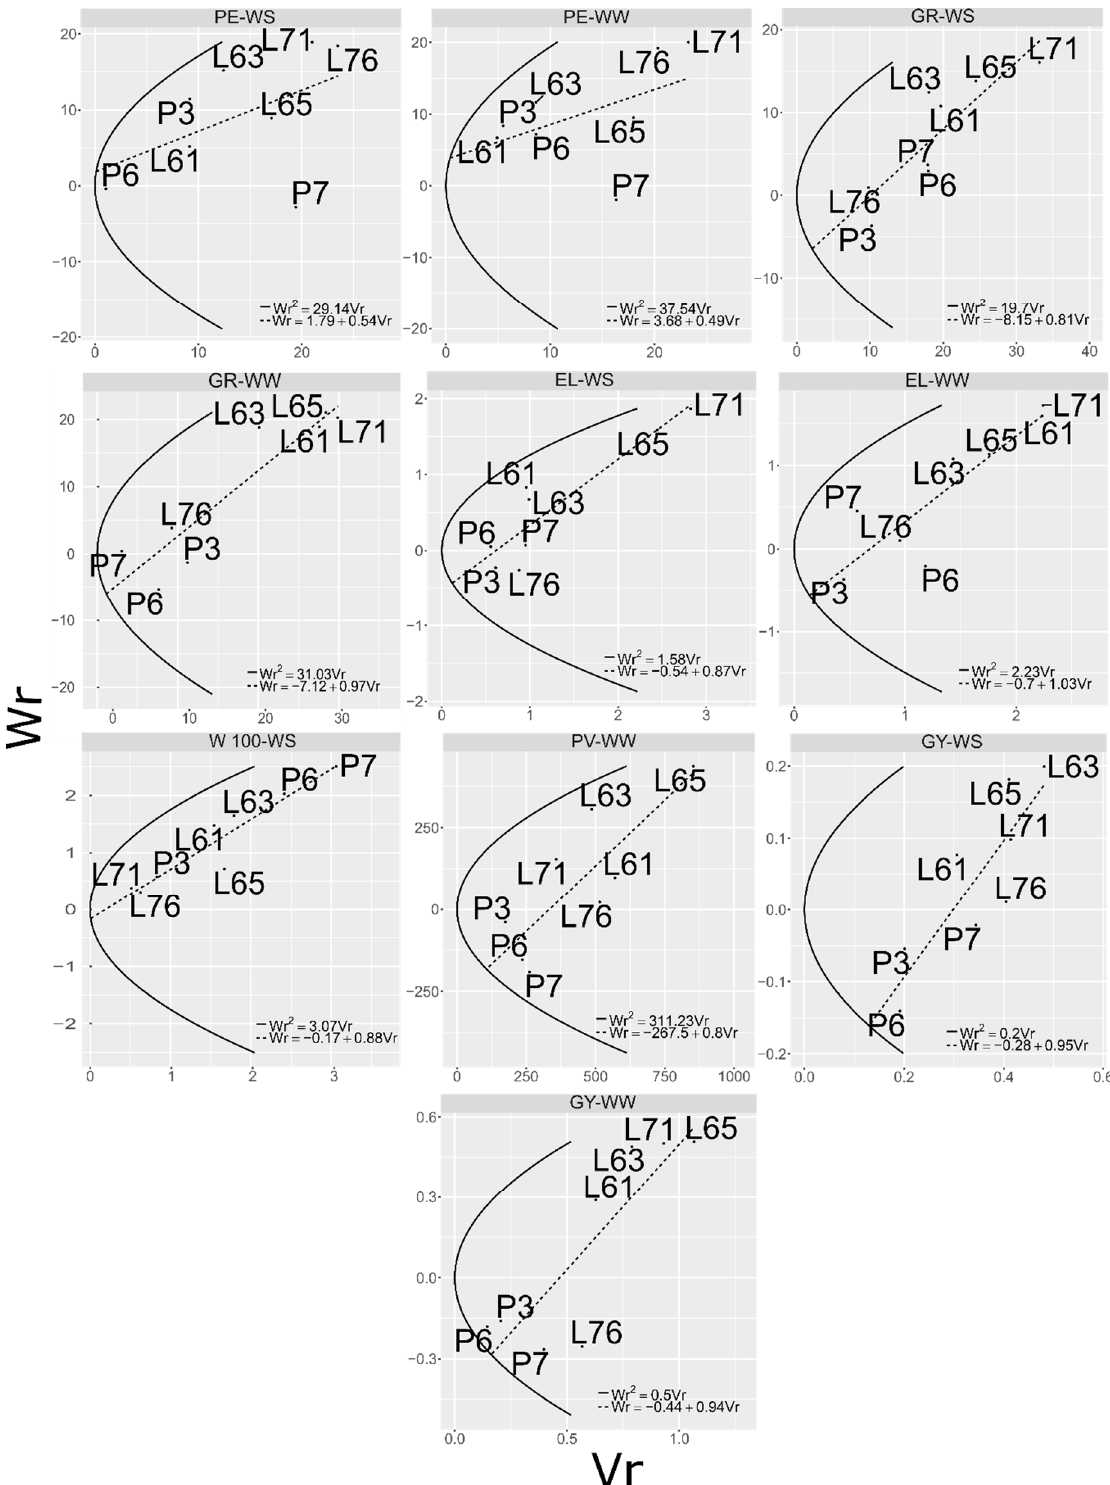
Figure 1. Straight line and parabola established by the relationships between covariance between parent means and means of the crosses with the parent ( W r ), with the means of the crosses with the parent ( V r ), of the traits evaluated in in popcorn genotypes under water-stress (WS) and well-watered (WW) conditions. PE: popping expansion; GY: grain yield; EL: ear length; GR: mean number of grains per row; W100: 100-grain weight; and PV: expanded popcorn volume per hectare.